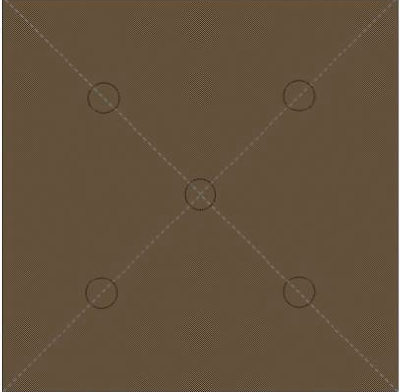
Figure 1. Sampling map of surface morphology of insulation pressboard.